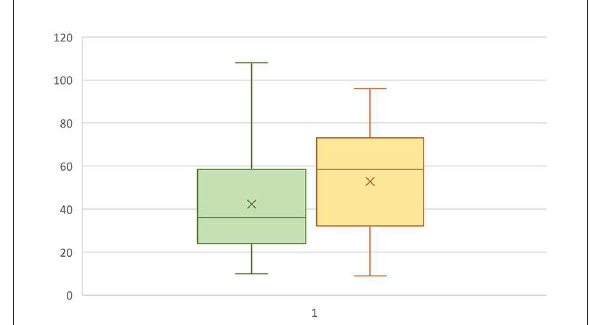
FIGURE1 Box plot representing the age at seizure onset in male (green) and female (yellow) IS dogs. The Y-axis represents months.